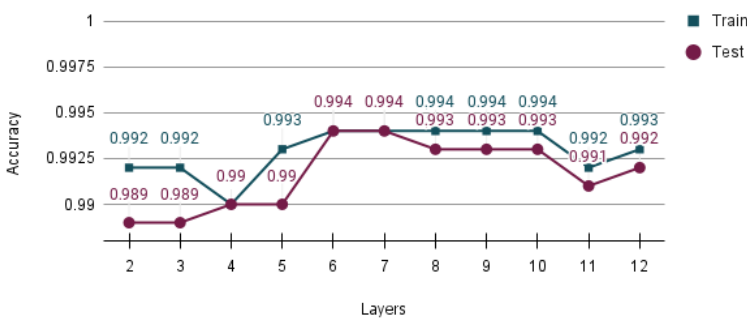
Figure 4. Evaluation of the dense neural network model according to the number of layers